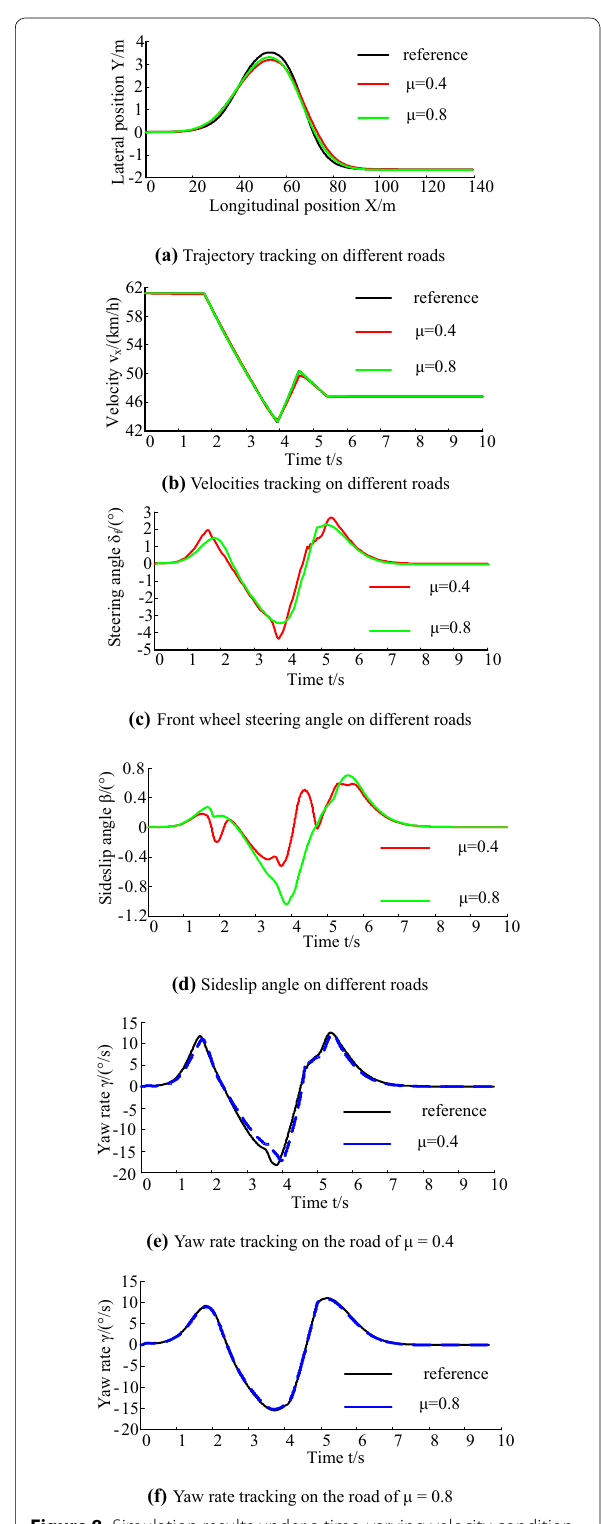
Figure 8 Simulation results under a time-varying velocity